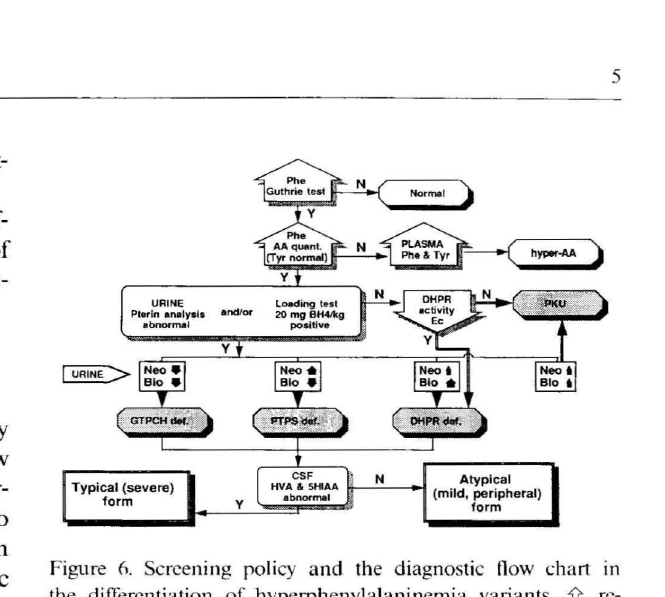
Figure 6. Screening policy and the diagnostic flow chart